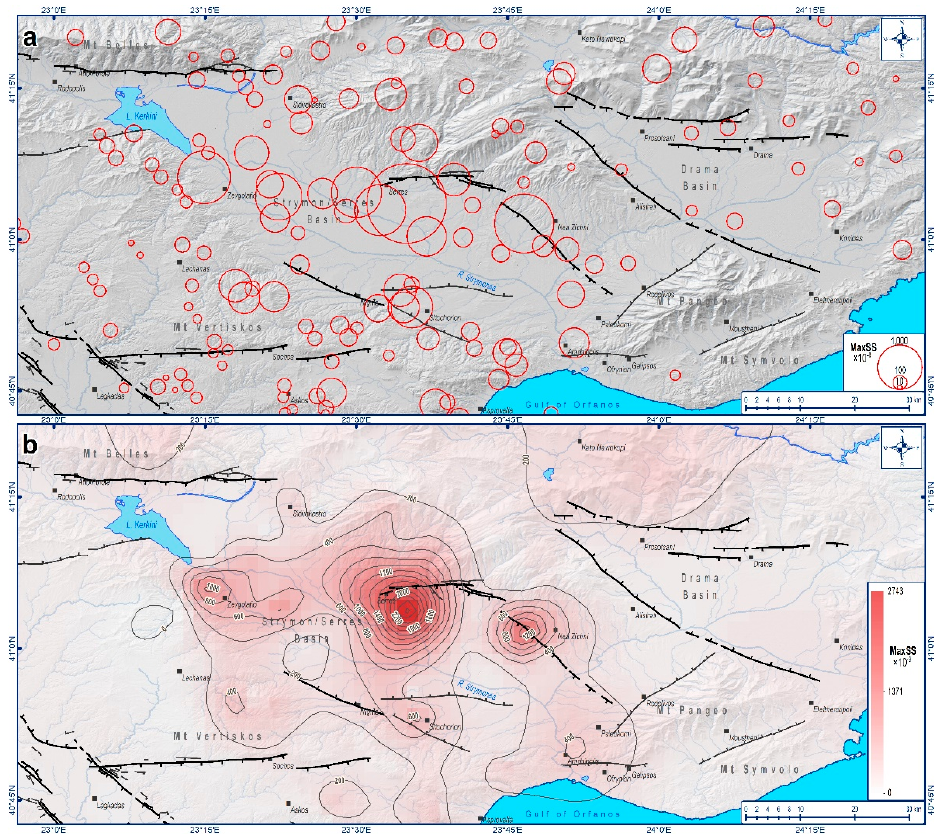
Figure 6. Maximum Shear Strain (MaxSS) in the broader Strymon area: ( a ) MaxSS values (red circles) of the total examination points; ( b ) MaxSS values grid, based on the interpolation (kriging) geostatistical analysis.